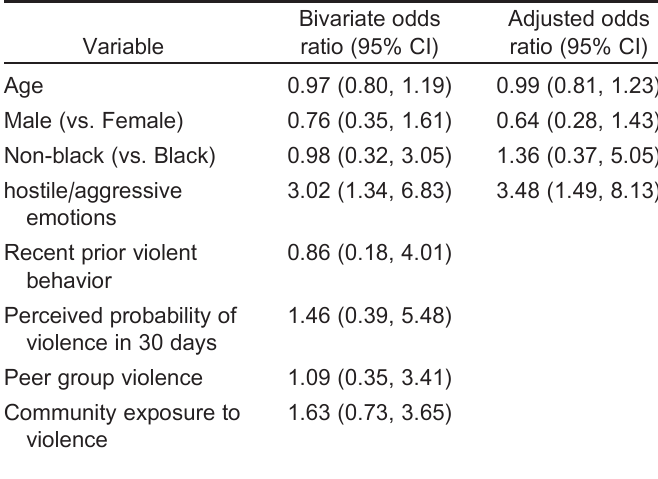
Table 5. Association of violence risk factors and demographic variables with presentation for injury in bivariate and multivariate logistic regression models.